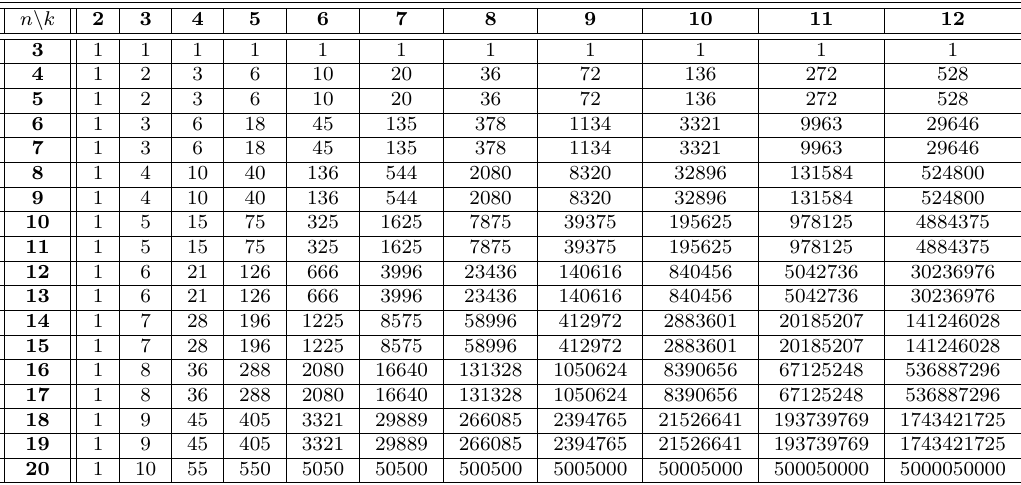
Table 1: Number on non isomorphic kC